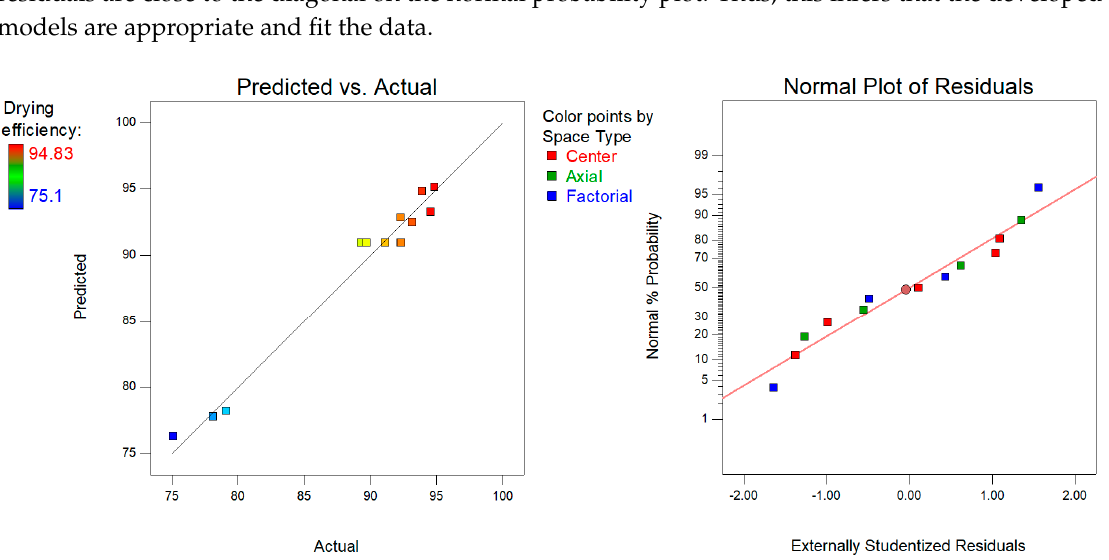
Figure 2. Residual plots: Predicted vs. actual ( left ); Normal residuals ( right ).